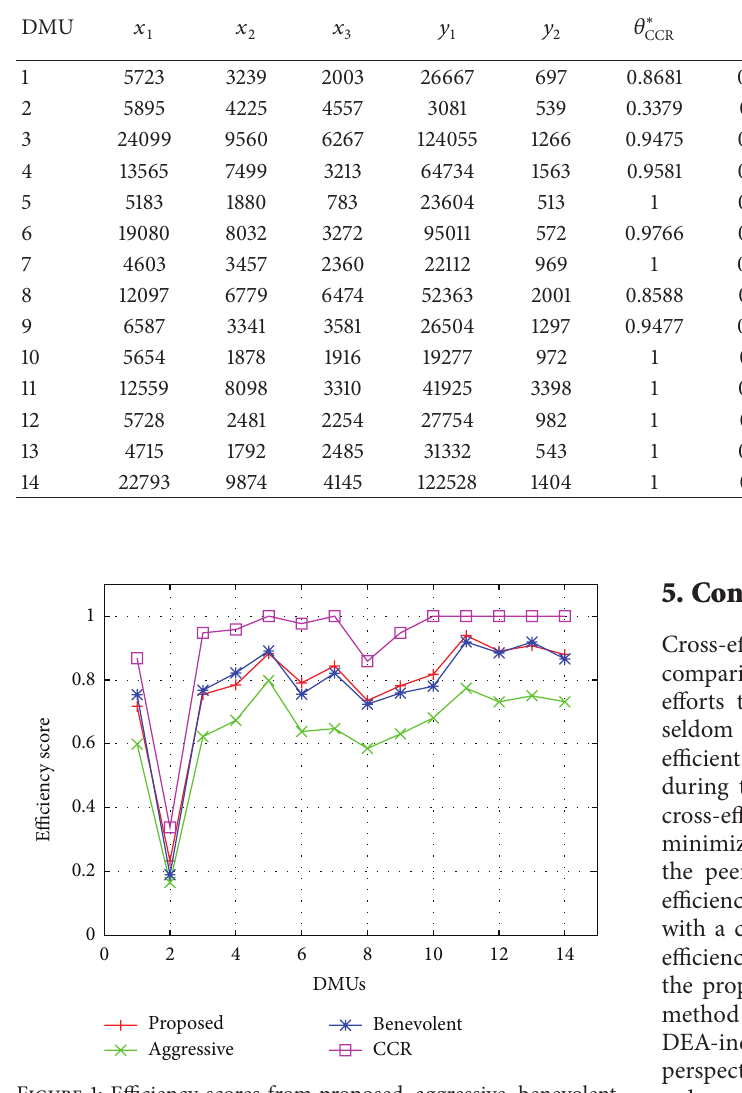
Figure 1: Efficiency scores from proposed, aggressive, benevolent model and CCR